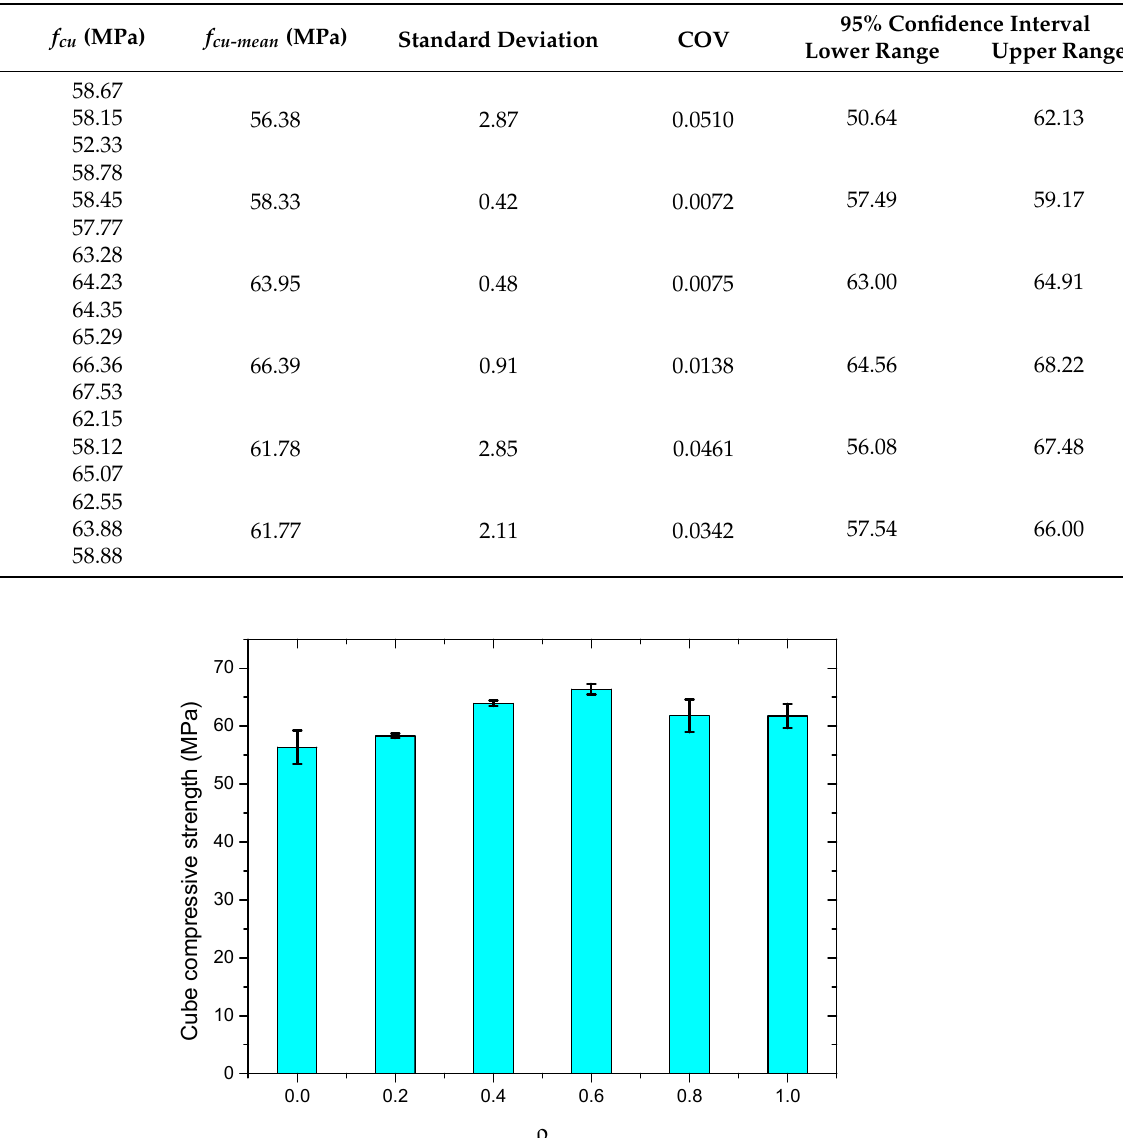
Table 8. Results of compressive tests of SWSSC with different mixes.